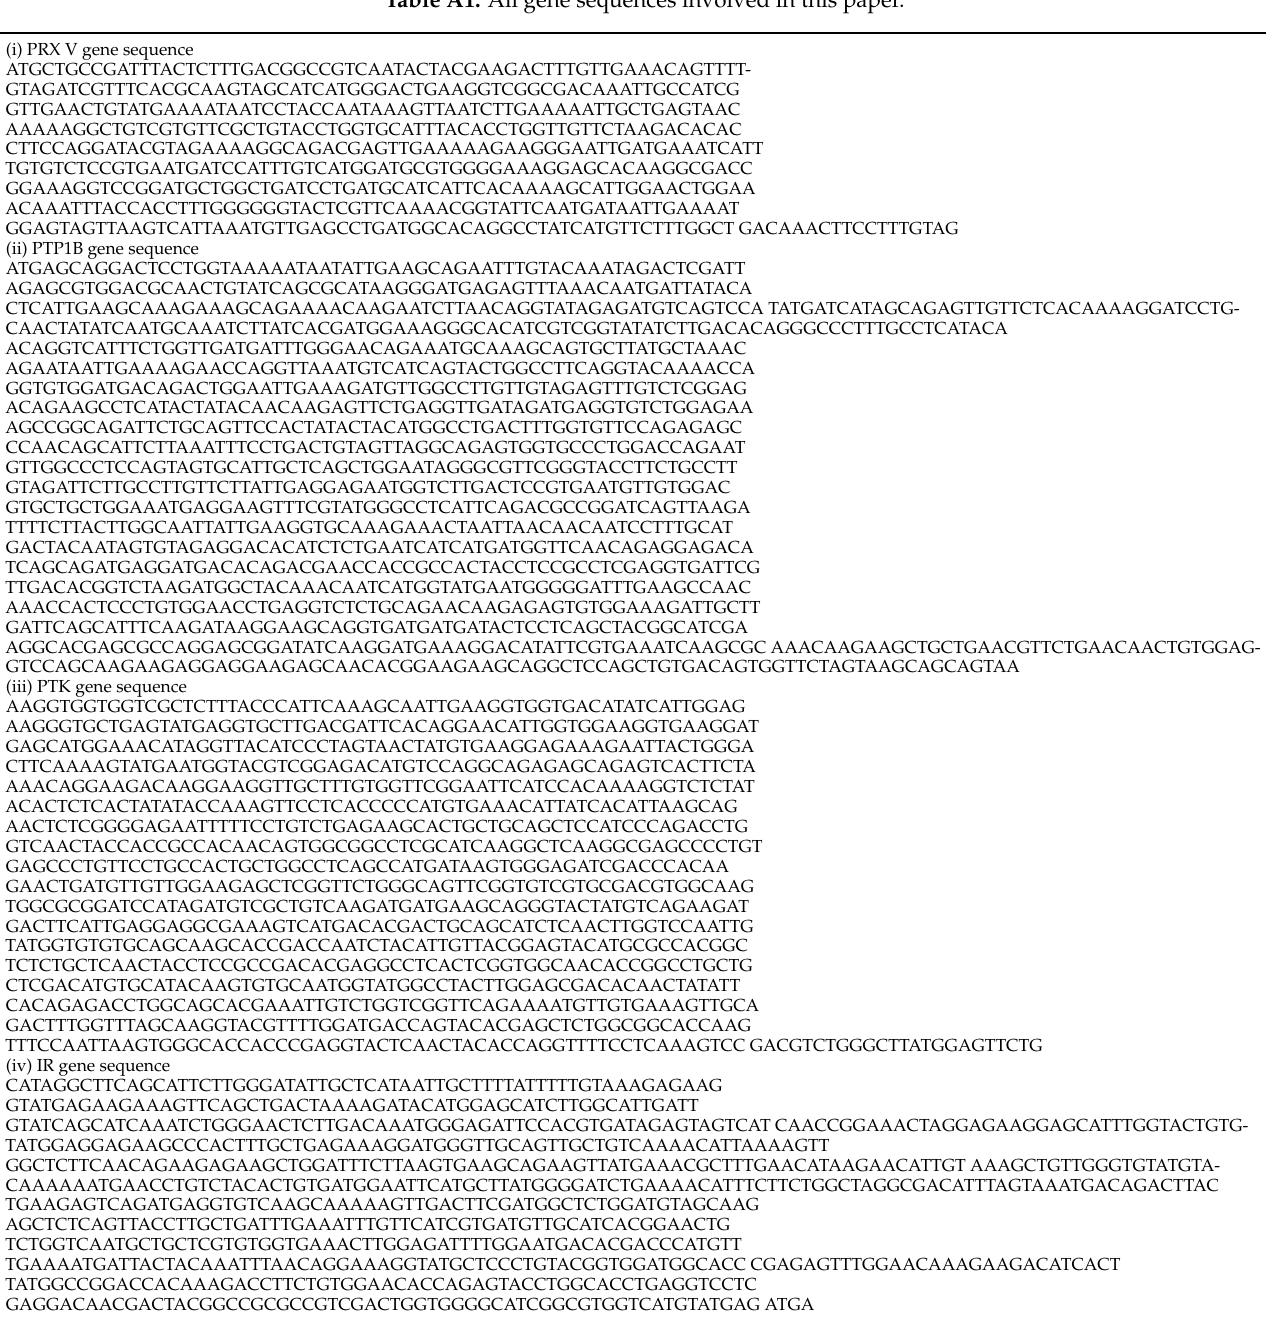
Table A1. All gene sequences involved in this